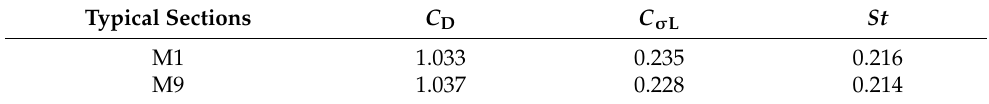
Table 3. Aerodynamic force coefficients and Strouhal number of the sections M1 and M9. Typical